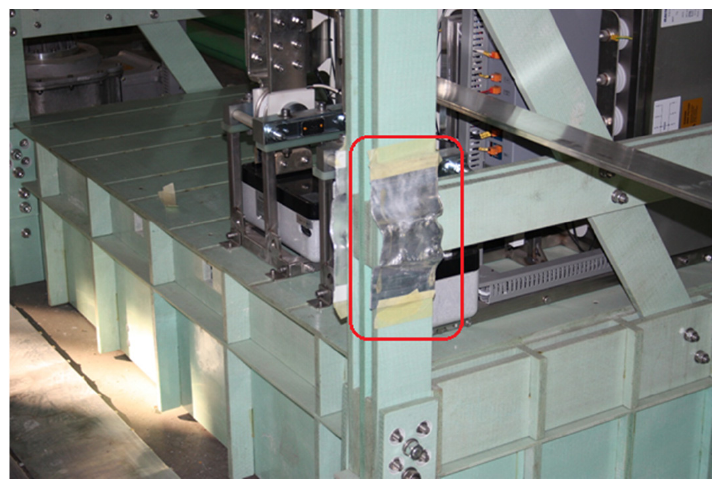
Figure 18. Metal bolts covered with metallic